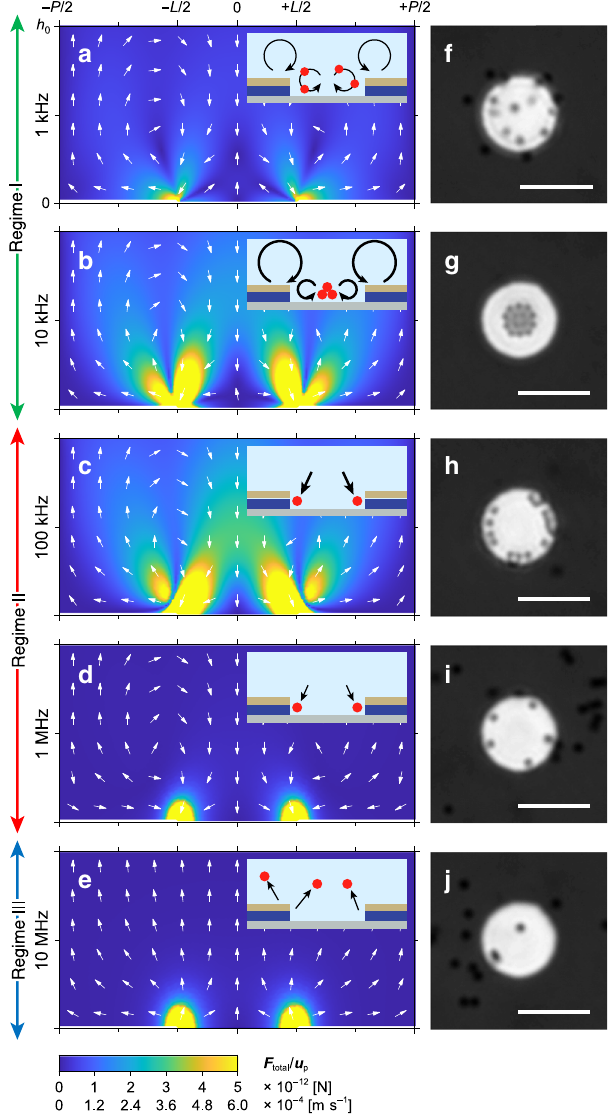
Fig. 3 Frequency-dependent particle movements on the VNE. a – j Cross- sectional simulations of F total and u p with schematics ( a – e ) and top-view of the experimental BF micrographs ( f – j ) of suspended 1 μ m PS particles on a single VNE under various AC frequencies; V pp = 2.5 V, f = 1 kHz ( a , f ), 10 kHz ( b , g ), 100 kHz ( c , h ), 1 MHz ( d , i ), and 10 MHz ( e , j ). Scale bars, 10 μ